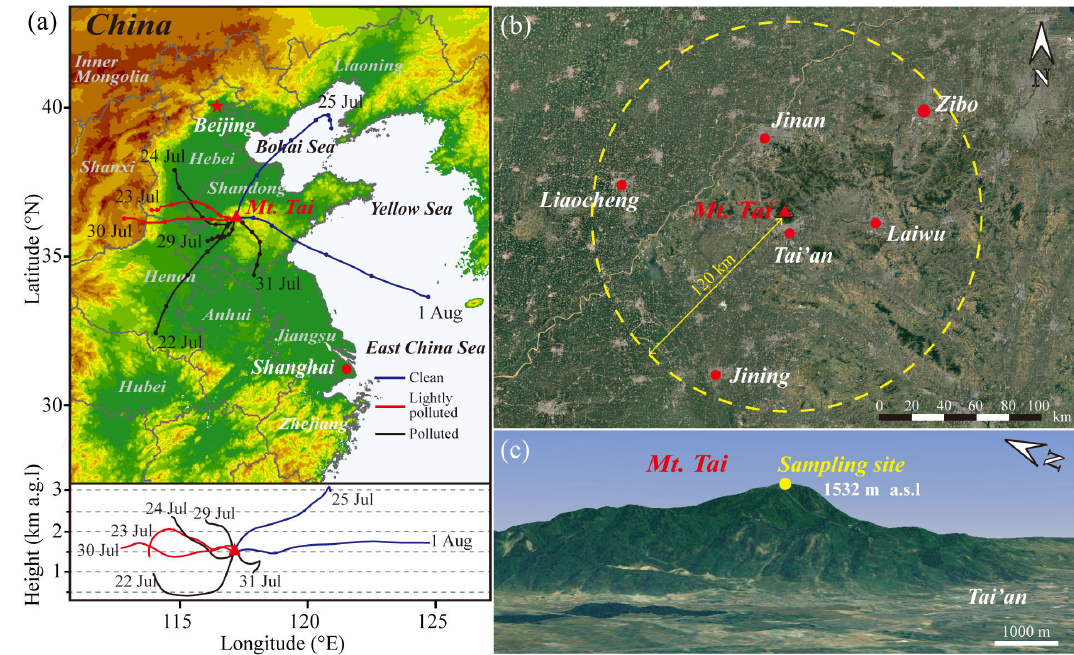
Figure 1. (a) Location of Mt. Tai in the North China Plain (NCP) and the 24h air mass backward trajectories arriving at Mt. Tai at 1500ma.g.l. during the sampling period. (b) The medium-sized industrial cities distributed within a radius of 120km around Mt. Tai. (c) The expanded topographic view of Mt. Tai and the sampling site near the summit of Mt.